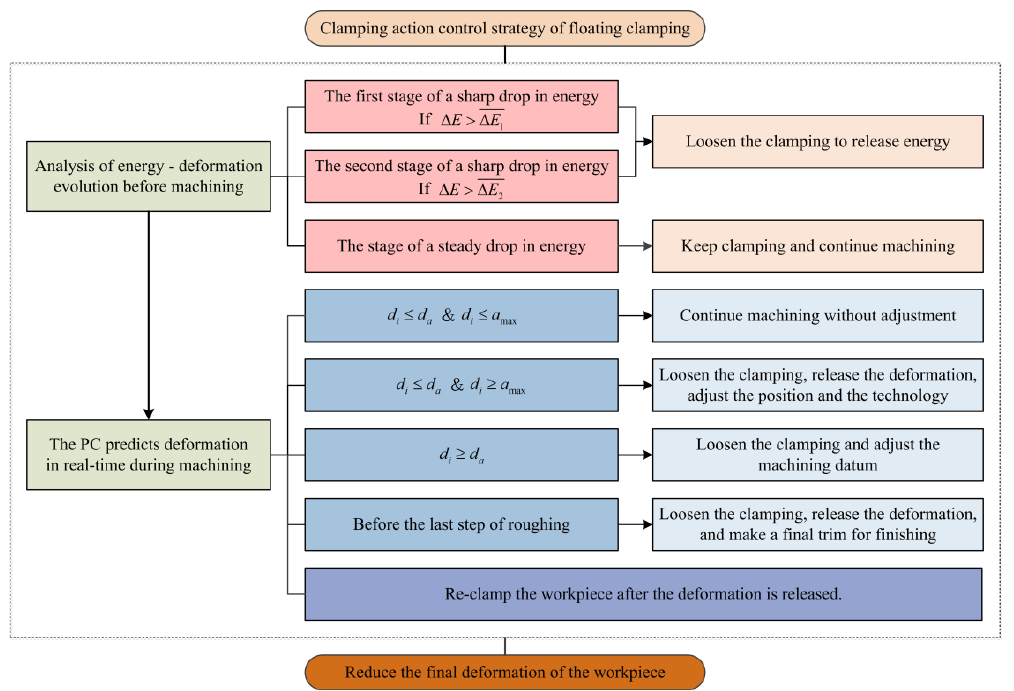
Figure 6. Clamping action control strategy for floating clamping machining.